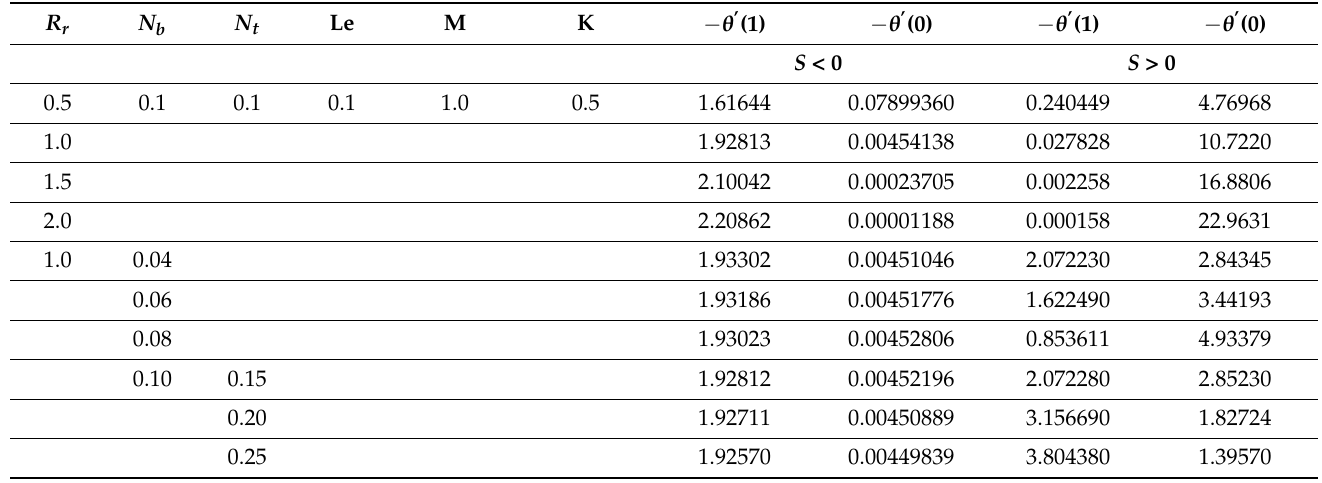
Table 8. Local Nusselt number for γ Al 2 O 3 − C 2 H 6 O 2 at lower and upper plane with strong interaction